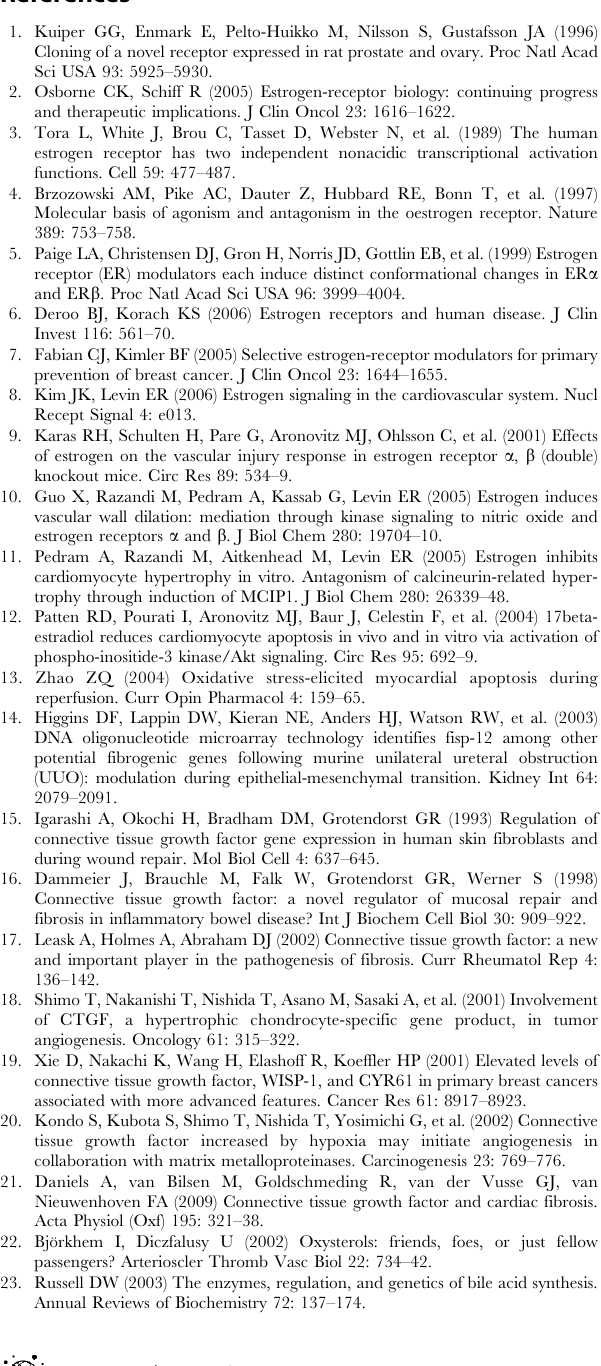
Figure S5 25HC (1 m M) induces FAS mRNA expression in SkBr3 cells, as evaluated by real time PCR. Data